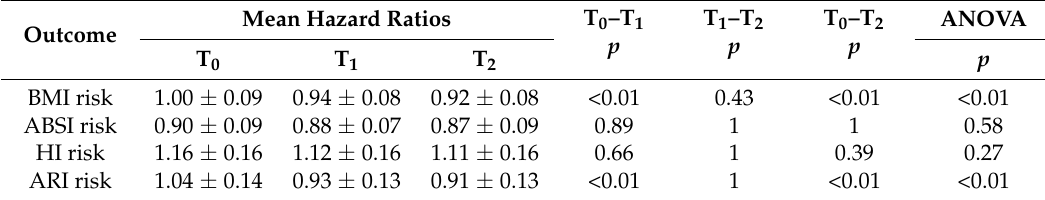
Table 2. Anthropometric risk measures from the start of the intervention to follow-up. Mean Hazard Ratios Outcome